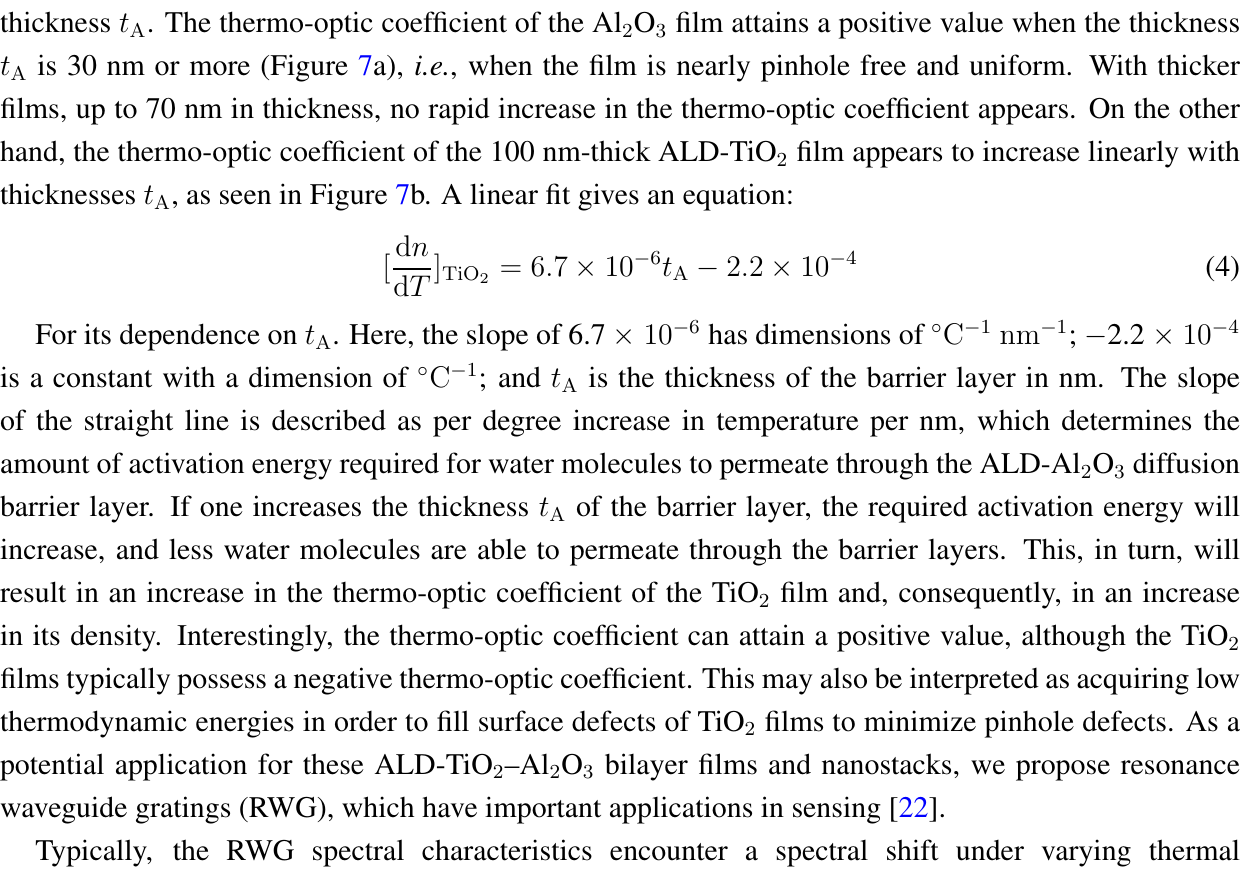
Figure 6. The atomic force microscopy (AFM) images of ( a ) a 100 nm-thick ALD-TiO film deposited on a Si substrate with a surface roughness value R 100 nm-thick ALD-TiO film with a 20 nm-thick ALD-Al 2 < 1 value R a